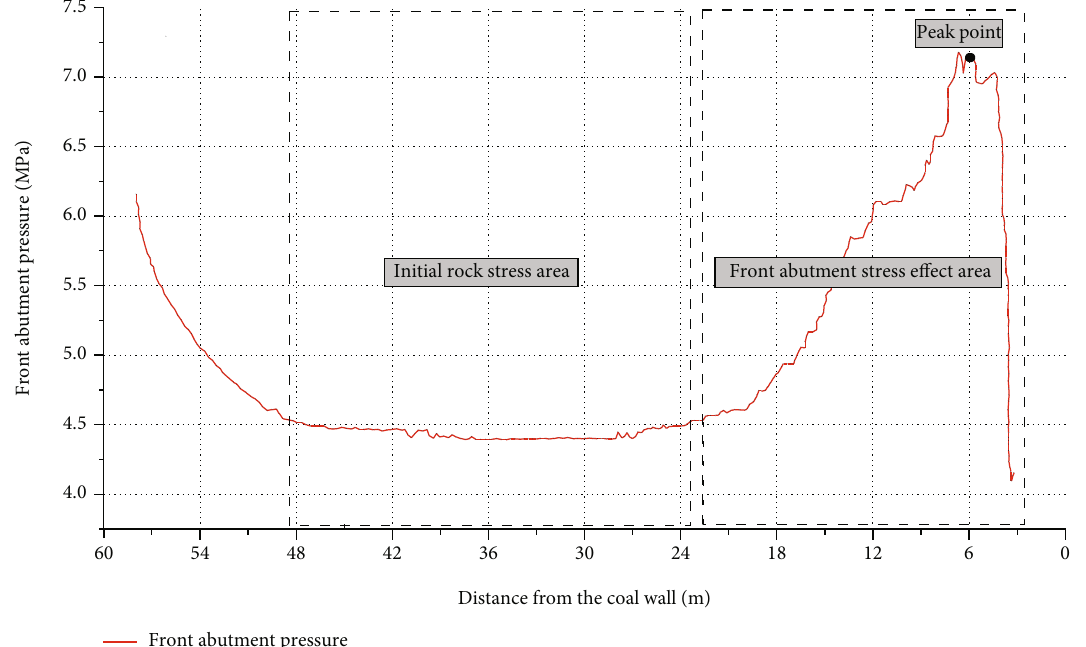
Figure 14: Front abutment pressure of No.1 borehole stress